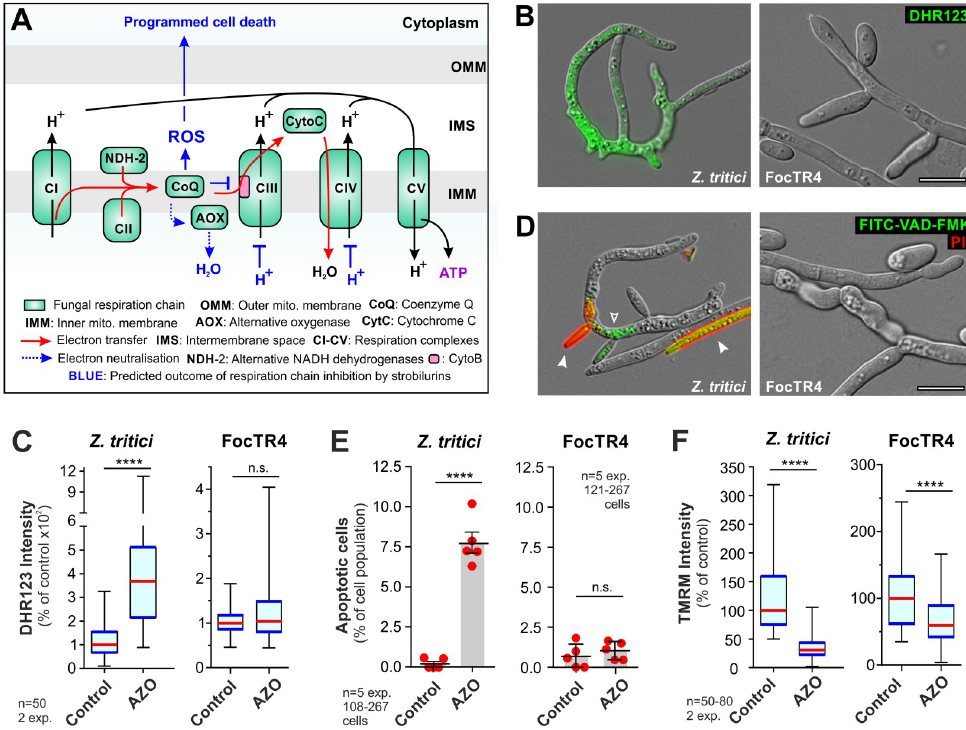
Fig 5. The effect of azoxystrobin on Z . tritici IPO323 and FocTR4. A Predicted effect of strobilurin on fungal respiration. Electrons are generated at complexes I and II, and by alternative NADH dehydrogenases. Coenzyme Q delivers them cytochrome b (Cytb) at complex III, from where they pass to cytochrome C (CytC) and arrive at complex IV (CIV) for neutralisation. This generates a proton gradient for ATP synthesis. Strobilurins block electron transfer Cytb (blue blunt arrow), which could form reactive oxygen species (ROS), known to trigger fungal apoptotic cell death [58]. Strobilurin-induced ROS was reported to be neutralised by fungal alternative oxidase (AOX, [55]), yet this enzyme is down-regulated in strobilurin persister cells. B Reactive oxygen species in Z . tritici IPO323 and FocTR4 cells, visualised with DHR123 (green). Both cell types were treated with 500 μ g ml -1 azoxystrobin for 24 h. Scale bar = 10 μ m. C ROS levels in azoxystrobin-treated Z . tritici and FocTR4 cells, visualised by DHR123 staining. D Apoptotic cells in Z . tritici IPO323, visualised with FITC-VAD(OMe)-FMK (green, open arrowhead). No apoptotic cells were found in FocTR4. Both cell types were treated with 500 μ g ml -1 azoxystrobin for 24 h. Dead cells appear yellow due to co-staining with red-fluorescent propidium iodide (closed arrowhead). Note that these cells were not included in ( E ). Scale bar = 10 μ m. E Apoptotic cells after treatment with azoxystrobin in Z . tritici and FocTR4, visualised by FITC-VAD(OMe)-FMK staining. F Mitochondrial membrane potential in azoxystrobin-treated Z . tritici and FocTR4 cells, treated with 500 μ g ml -1 azoxystrobin and visualised by staining with the voltage-sensitive dye TMRM.FocTR4 persister cells maintained 66.1 ± 4.0% (n = 80) of their mitochondrial polarization. IPO323 cells 35.5 ± 3.1% (n = 50 cells). In ( C—F ) 500 μ g ml -1 azoxystrobin was applied for 24 h. Control indicates the use of an equivalent volume of the solvent methanol. Non- normally distributed data in ( C , F ; Shapiro-Wilk test, P < 0.05) shown as Whiskers’ plots with 25/75 percentiles (blue lines) and median (red lines); bars in ( E ) represent mean ± SEM, red dots represent independent experiments; sample sizes indicated; statistical analysis used non-parametric Mann-Whitney testing ( C , F ), or Student’s t-testing with Welch correction ( E ); n.s. = non-significant difference to control at two-tailed P = 0.2144 ( C ) and P = 0.4264 ( E ); ���� = significant difference to control at two-tailed P < 0.0001 ( C , E , F